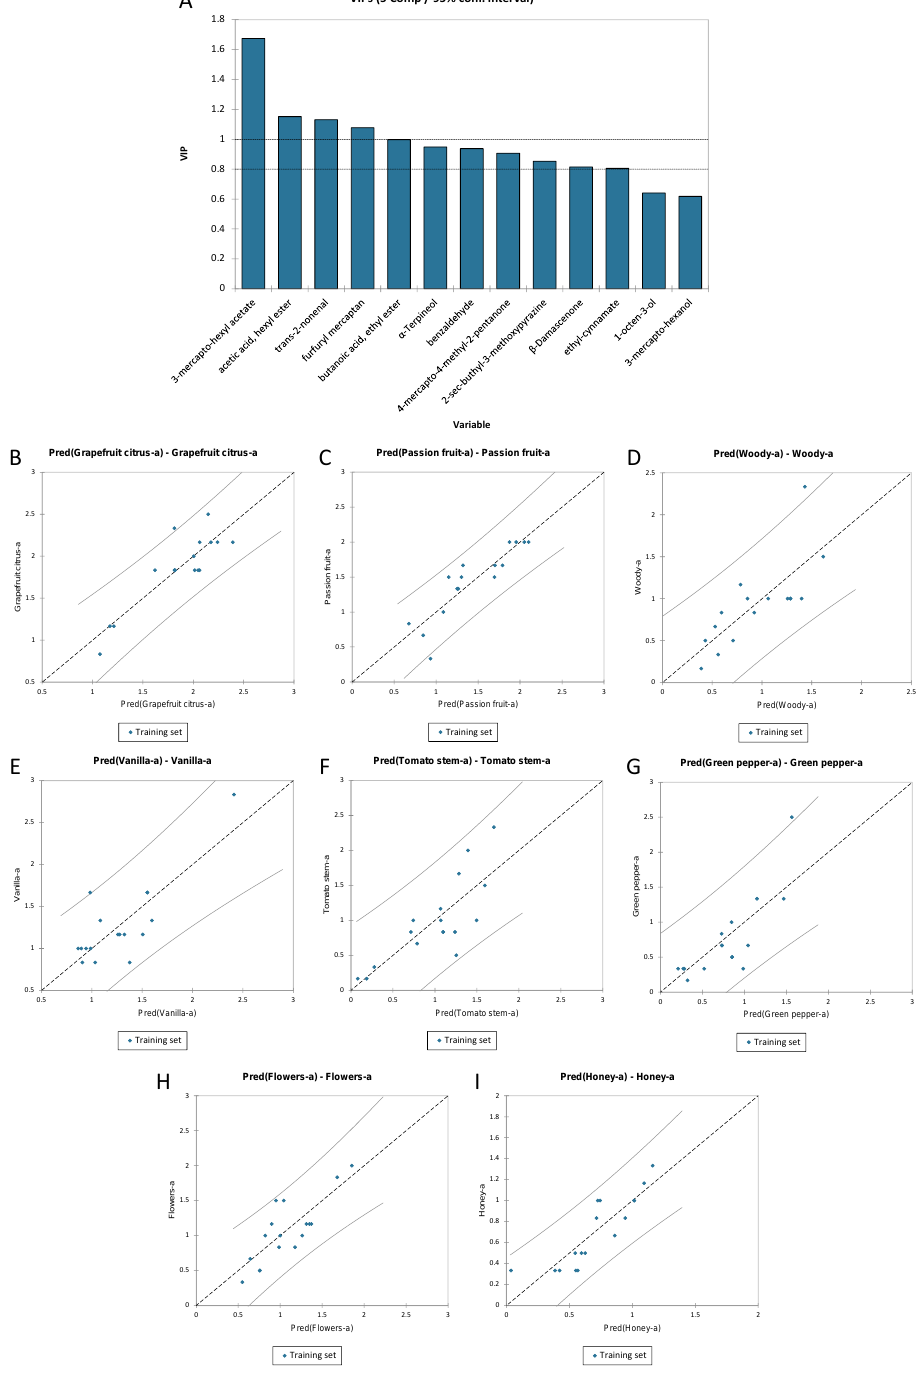
Figure 9. ( A ) shows the variable importance in projection (VIP) in the PLS regression olfactory attributes vs. volatile compounds. Figure from ( B – I ) show the regression graphs predicted vs. experiment data for olfactory attributes in the Sauvignon Blanc wines.